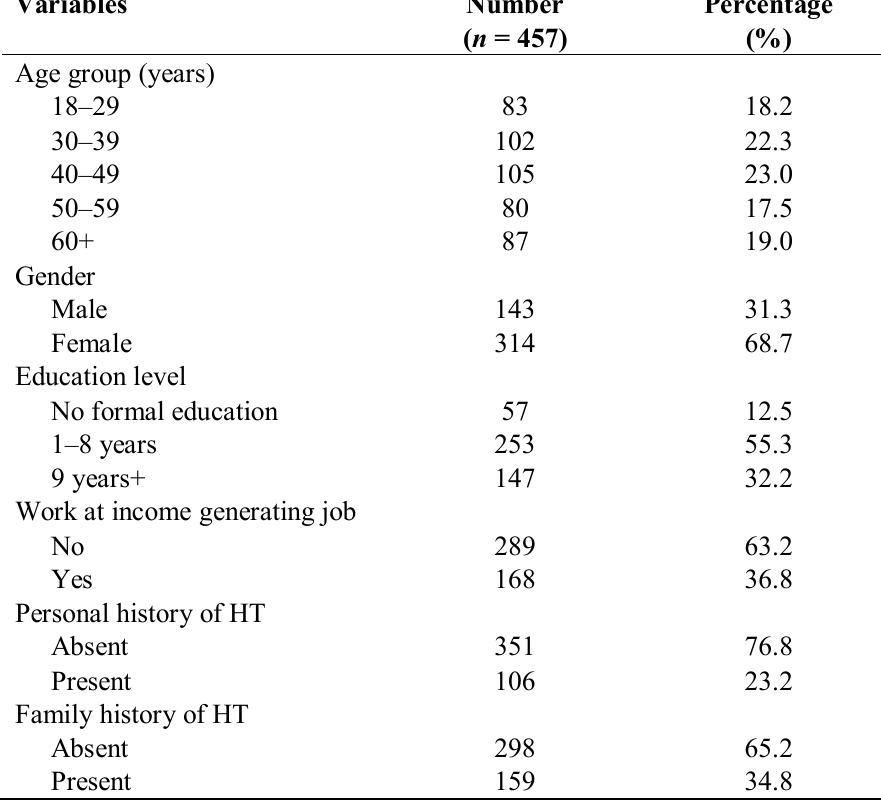
Table 1. Distribution of the study group according to various demographic and medical